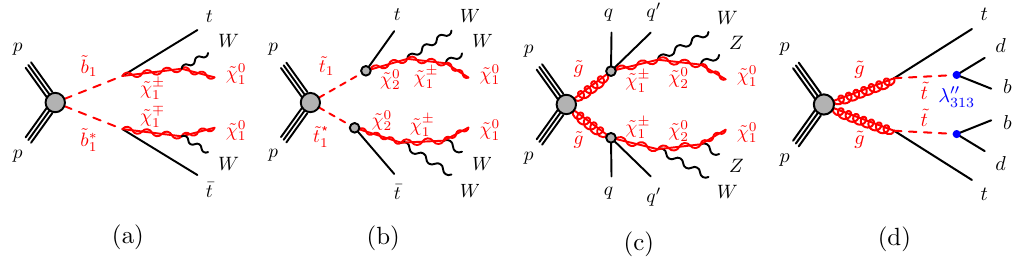
Figure 1. Examples of processes allowed in the MSSM, involving the pair production and cascade decays of squarks and gluinos into (cid:12)nal states with leptons and